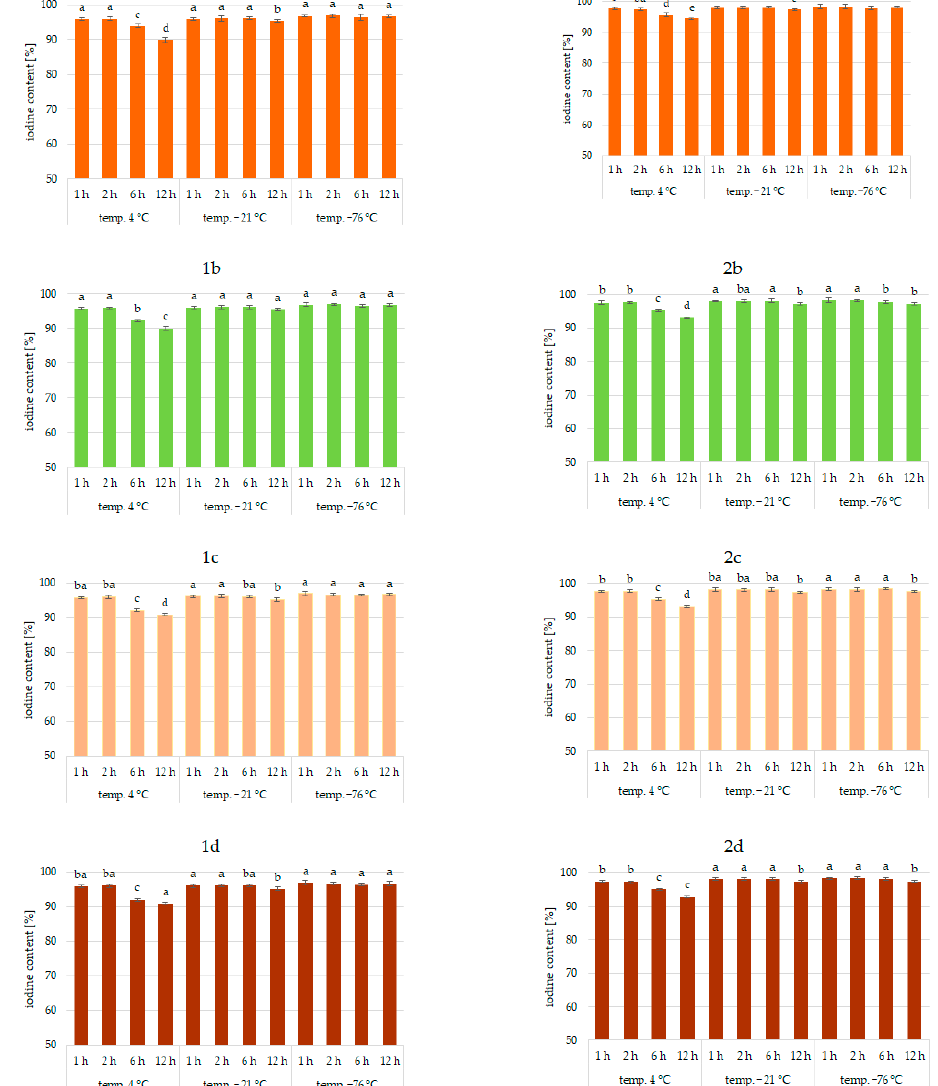
Figure 1. Iodine content (%) in pumpkin ( 1a , 2a ), broccoli ( 1b , 2b ), cauliflower ( 1c , 2c ), and carrot ( 1d , 2d ) fortified with KI and KIO 3 , respectively, at hydration ratio 1:1 and different temperatures (4 °C, − 21 °C, − 76 °C) and times; different letters (a–e) denote a significant difference at p < 0.05 (one-way ANOVA, and post hoc Tukey test). Mean values ( n = 4). Error bars are confidence intervals with a confi-dence coefficient of 0.95.